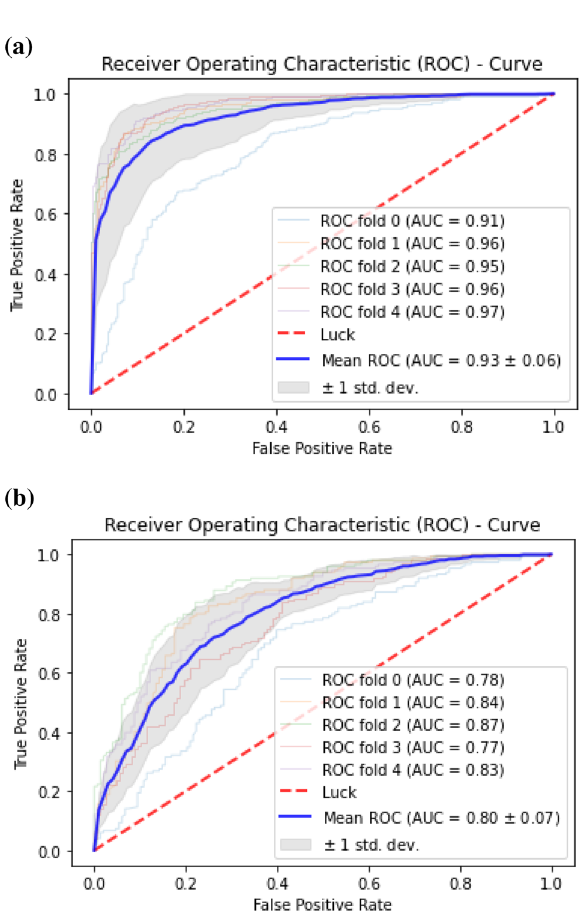
Figure 9. ( a ) ROC curve of fivefold cross validation tests for enhancers. ( b ) ROC curve of fivefold cross validation tests for enhancer